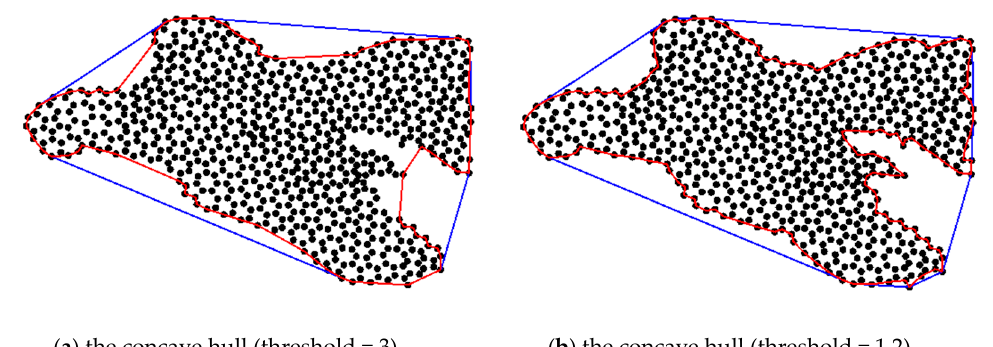
Figure 3. The generated convex (blue line) and concave (red line) hulls of particle clouds (black points).